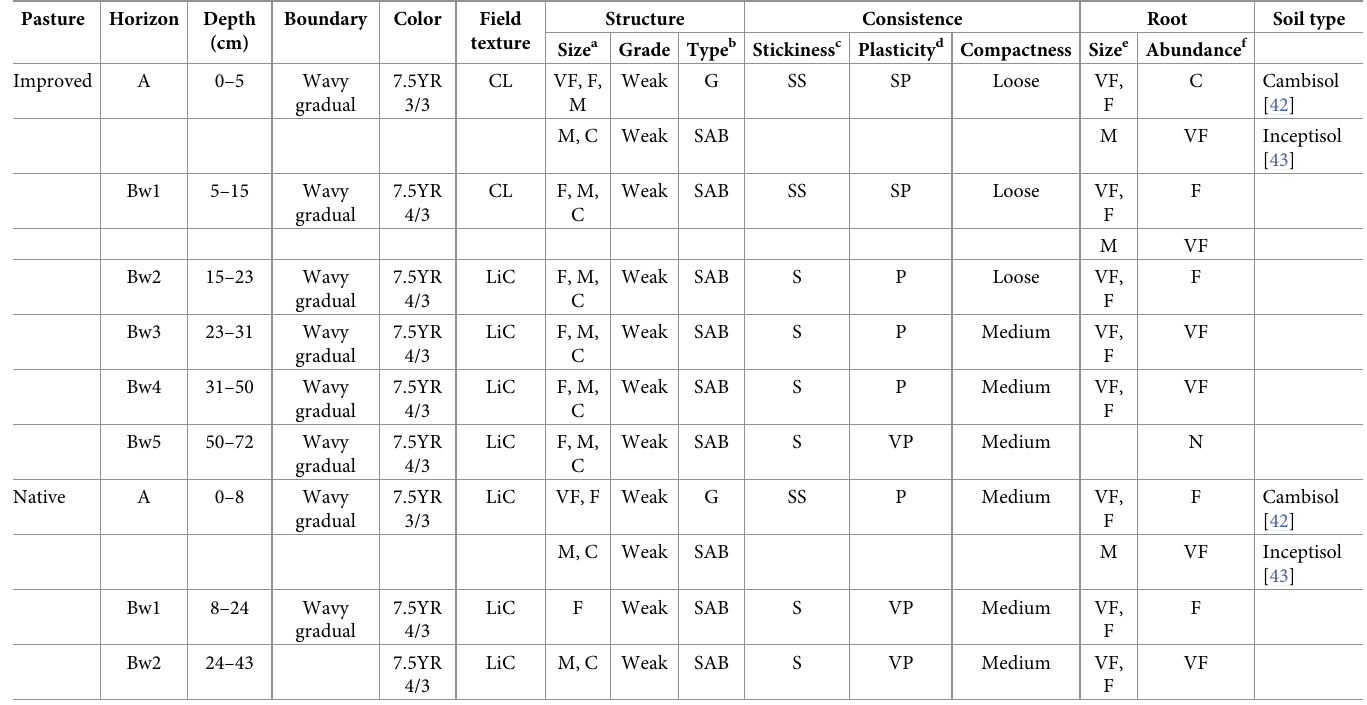
Table 2. Soil profiles in the two pastures. Pasture Horizon Depth (cm)